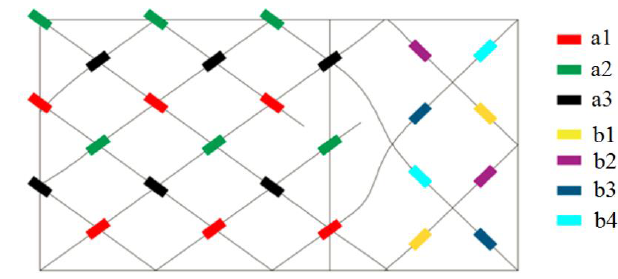
Figure 6. Schematic diagram of the sensor-equivalent measurement